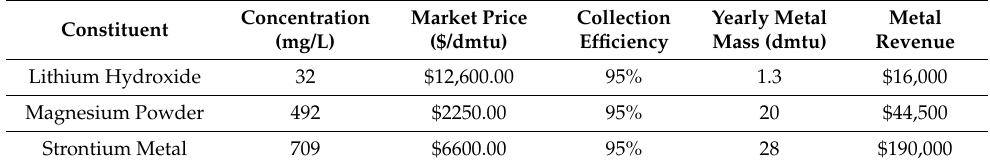
Table 2. Potential market benefits obtained from the sale of mineral extractions.